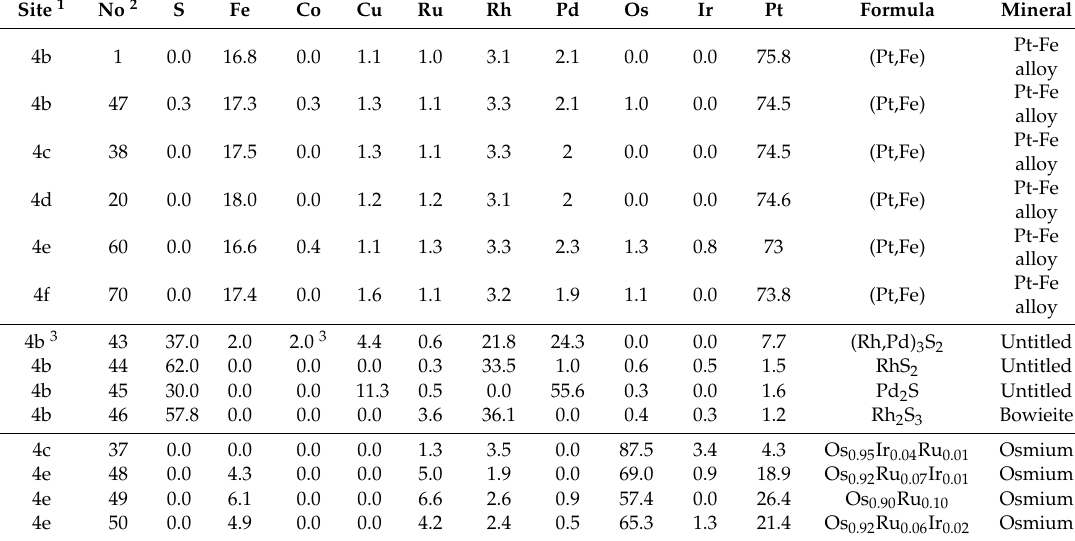
Table 7. The composition of the core in grain No. 3 (Figure 4) and its inclusions and micro lamellae (at.%), determined by the SEM-EDS